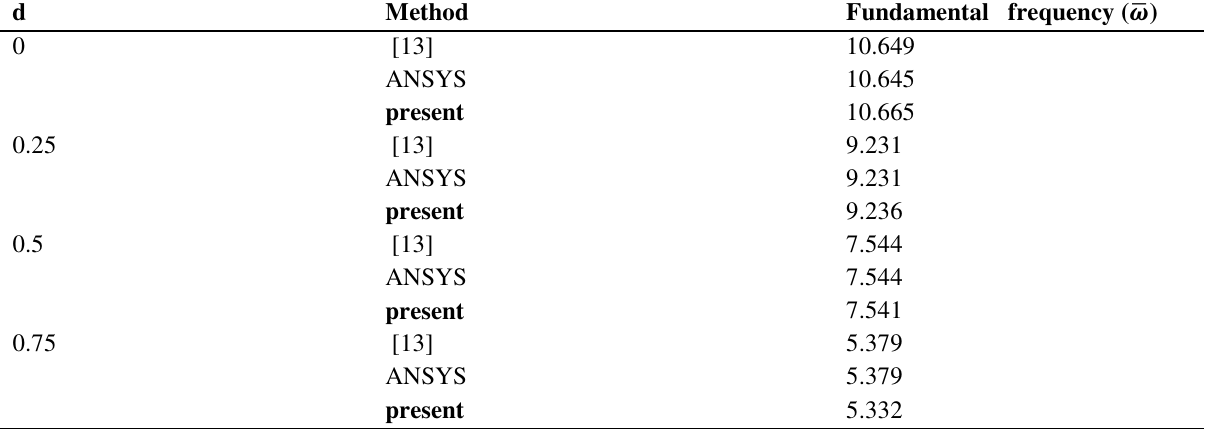
Dimensionless natural frequency of a laminated plate under buckling different ratio